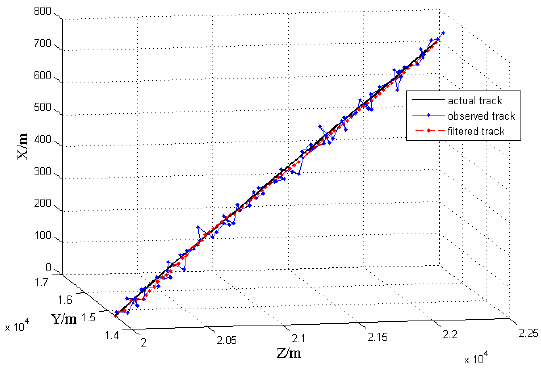
Figure 12. Localization track.